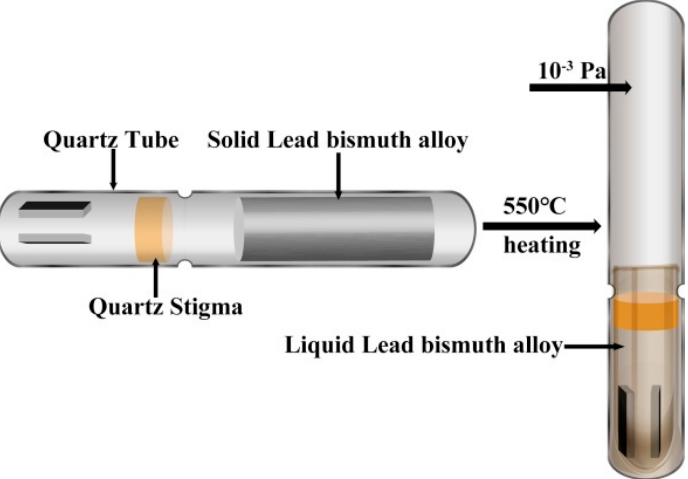
Figure 1. The design of experimental container for the liquid LBE corrosion testing.